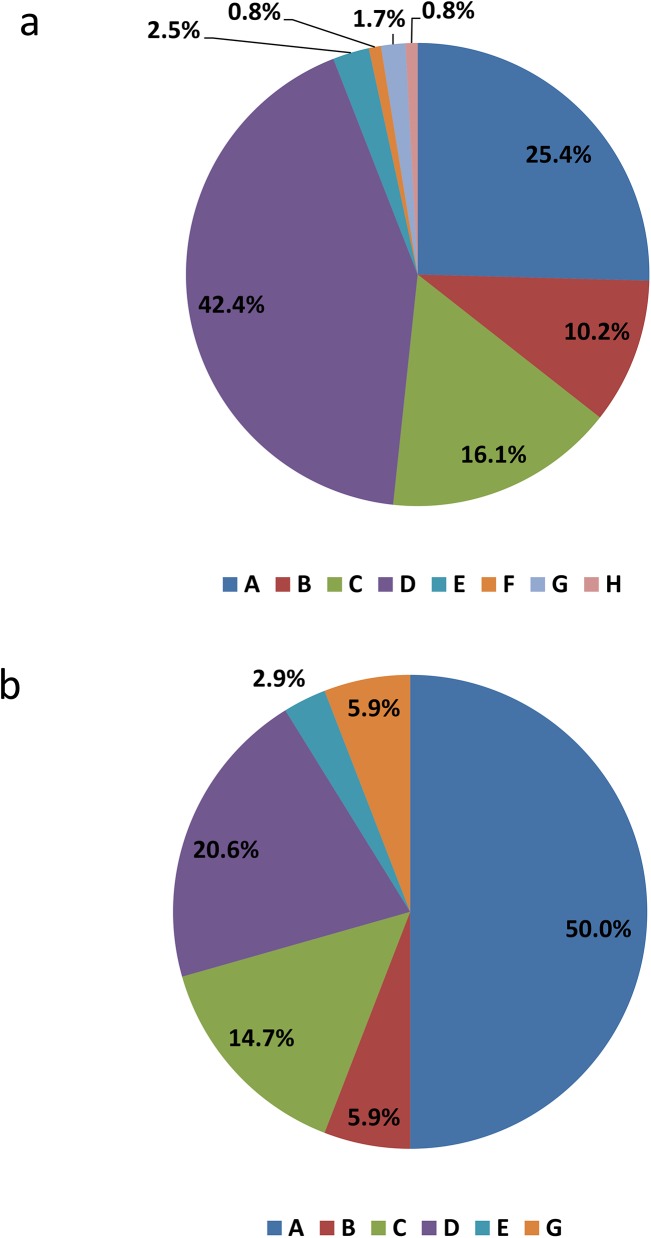
Genotype distribution for acute HBV cases from Western Canada (n = 118; a), and Central Canada (n = 34; b).